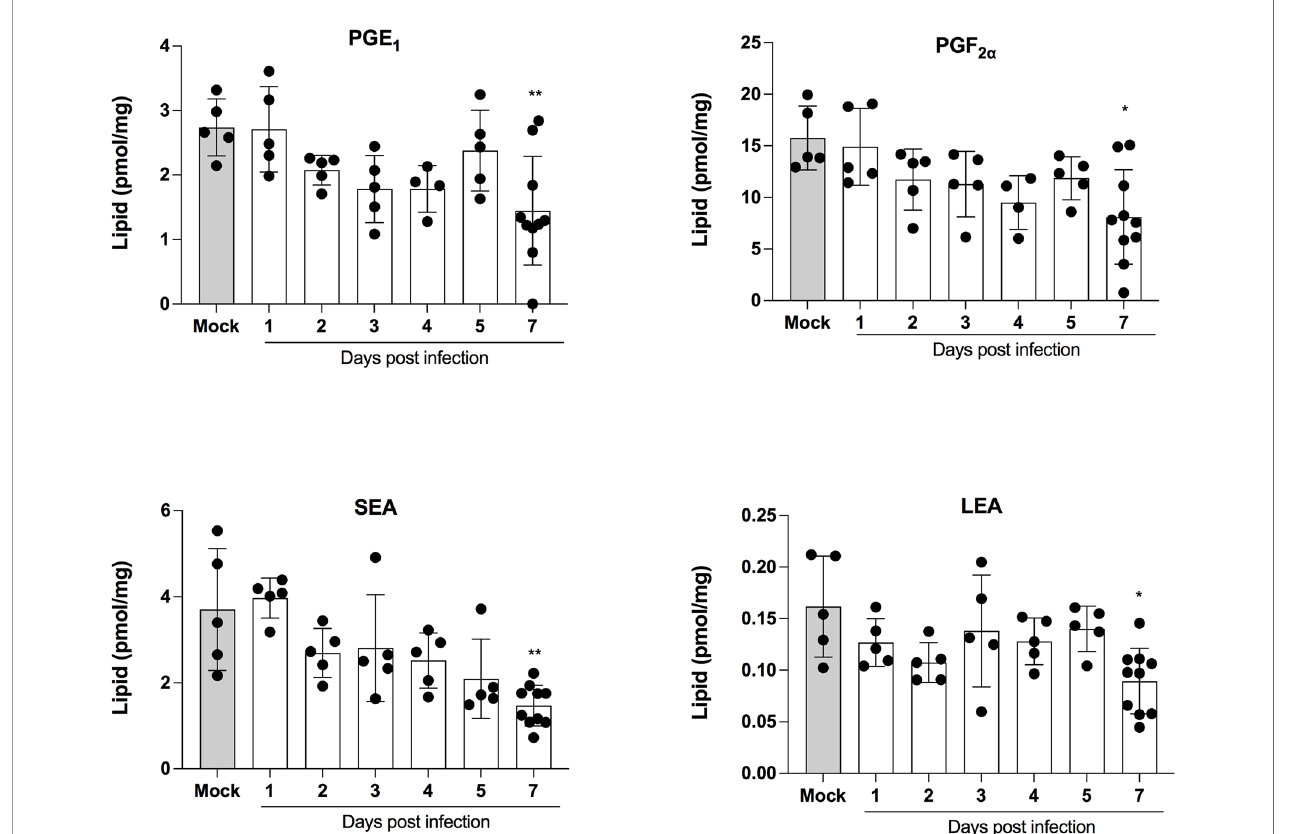
FIGURE 8 | Lipid mediators that are decreased in lungs of SARS-CoV-2 infected mice. Lung homogenates corresponding to 10 mg of tissues were heated at 60 ˚ C for 30 minutes in presence of 1 volume of methanol containing deuterated internal standards. Samples then were processed as in Archambault et al (11) to extract the lipid mediators and were analyzed by LC-MS/MS using a previously described analytical method (15). P values were determined using the Kruskall-Wallis test, with p values <0.05 considered statistically signi fi cant. *p<0.05,